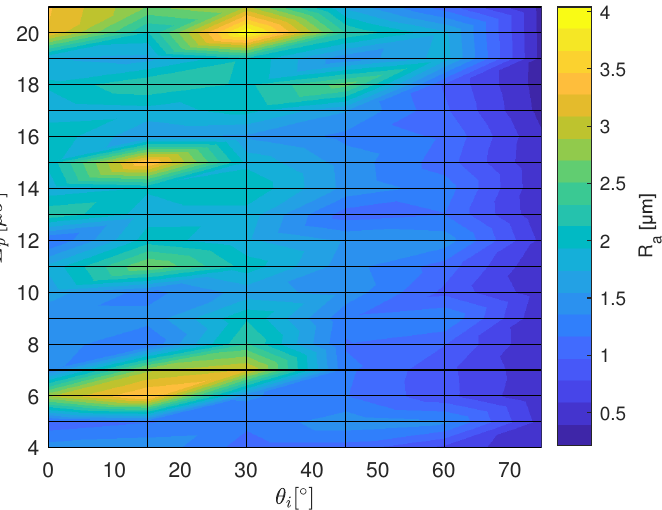
Figure 9. Ra values measured on the SiAlON ceramic LST 320 for the range of pulse energies and the tilt angles from the calibration experiment (see Figure